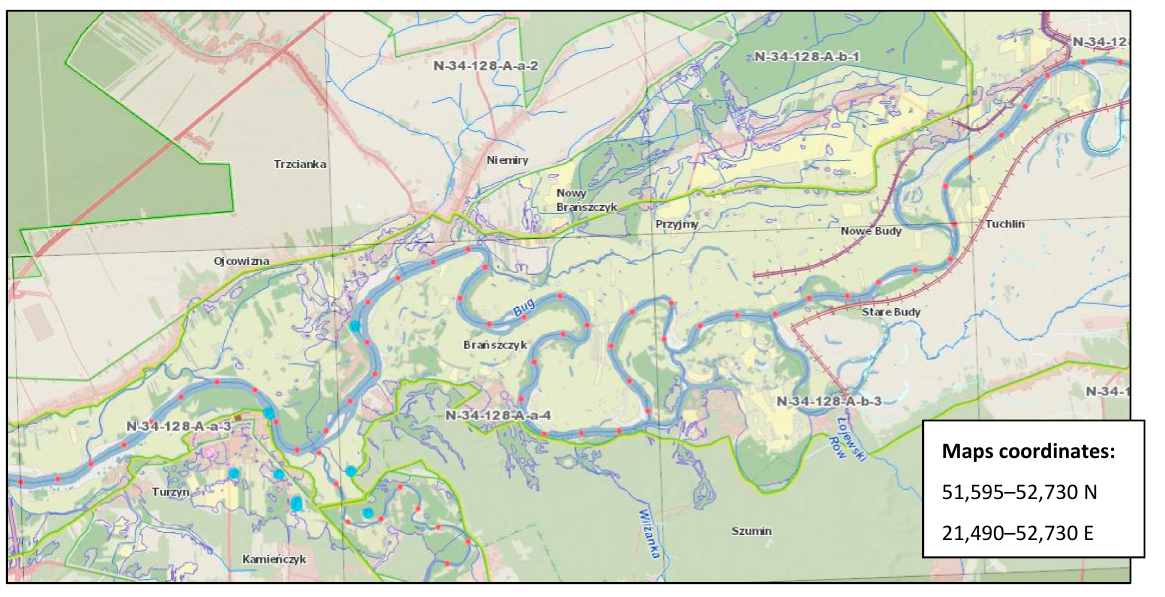
Figure 4. Location of Bra ń szczyk commune and map sheets used for flood risk assessment. Source: Developed using ISOK [37].